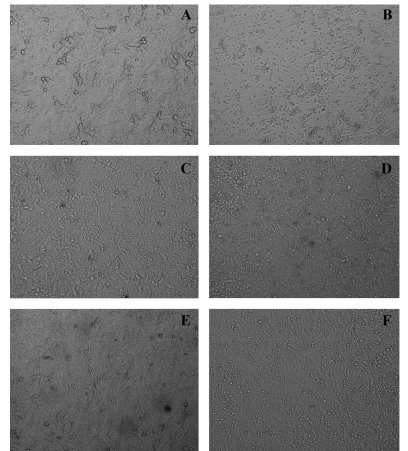
Figure 4. Antiviral effect against Zika virus in Vero cells treated with ethanol extract of leaves and quercetin. Vero cells were infected with ZIKV, treated with ethanol extract of leaves/quercetin, and photographed after 48 h of infection. ( A) Uninfected and untreated cells, ( B ) infected cells, ( C ) cells uninfected and treated with ethanol extract of leaves (85 µ g/mL), ( D ) cells infected and treated with ethanol extract of leaves (85 µ g/mL), ( E ) cells uninfected and treated with quercetin (20 µ g/mL), ( F ) cells infected and treated with quercetin (20 µ g/mL). Magnification,